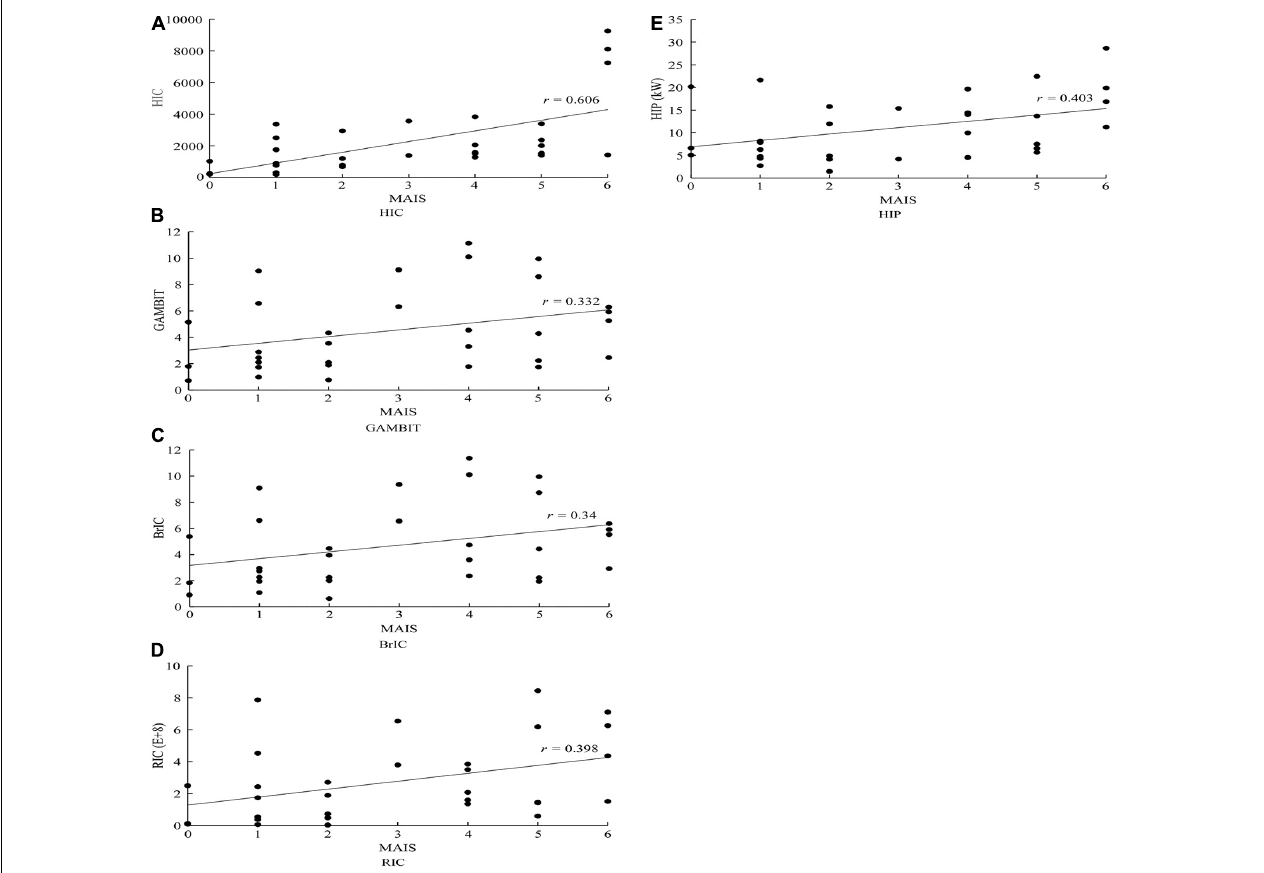
FIGURE 10 | Distribution of predicted head kinematics-based injury criteria and MAIS scores observed in the analyzed VRU impact accident cases. (A) HIC; (B) GAMBIT; (C) BrIC; (D) RIC; and (E) HIP. MAIS, Maximum Abbreviated Injury Scale; VRU, vulnerable road user; HIC, head injury criterion; GAMBIT, Generalized Acceleration Model for Brain Injury Threshold; MAIS, Maximum Abbreviated Injury Scale; RIC, rotational injury criterion; HIP, head impact power.